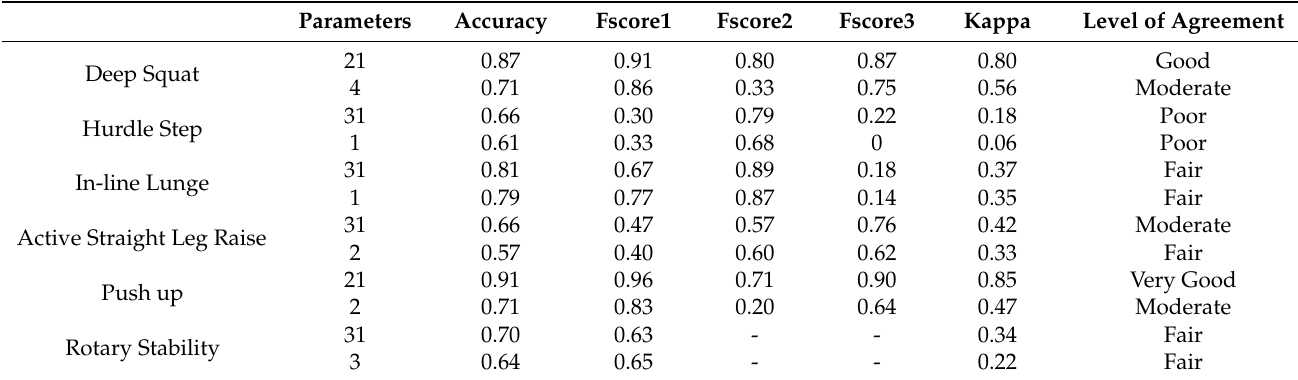
Table 5. The accuracy and F score of the classification, corresponding kappa values, and levels of agreement before feature selection and after feature